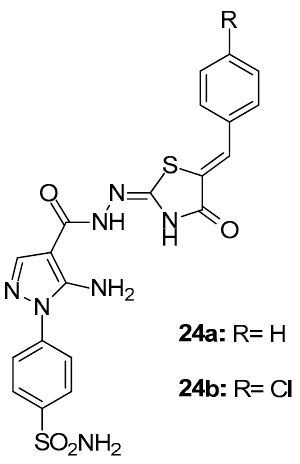
Figure 26. Chemical structures of pyrazolyl benzenesulfonamide derivatives 24a , 24b .